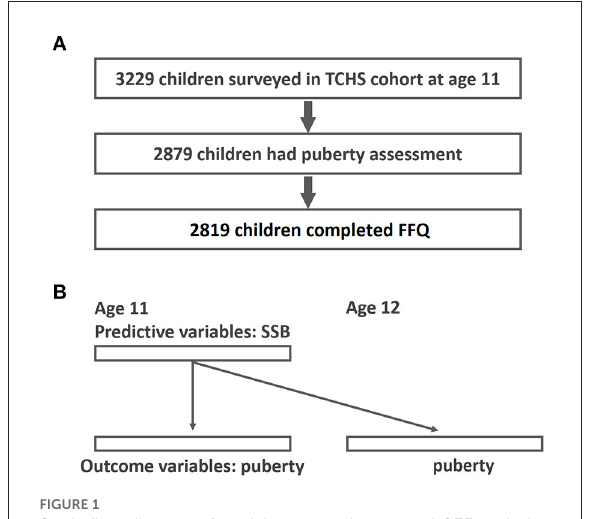
FIGURE1 Study flow diagram of participant recruitment and GEE analysis for the associations of SSB and early puberty. (A) Study flow; (B) GEE analysis-time lag model of the associations between SSB and early puberty (predictive variables were SSB at age 11 and outcome variables were puberty outcomes at age 11 and age